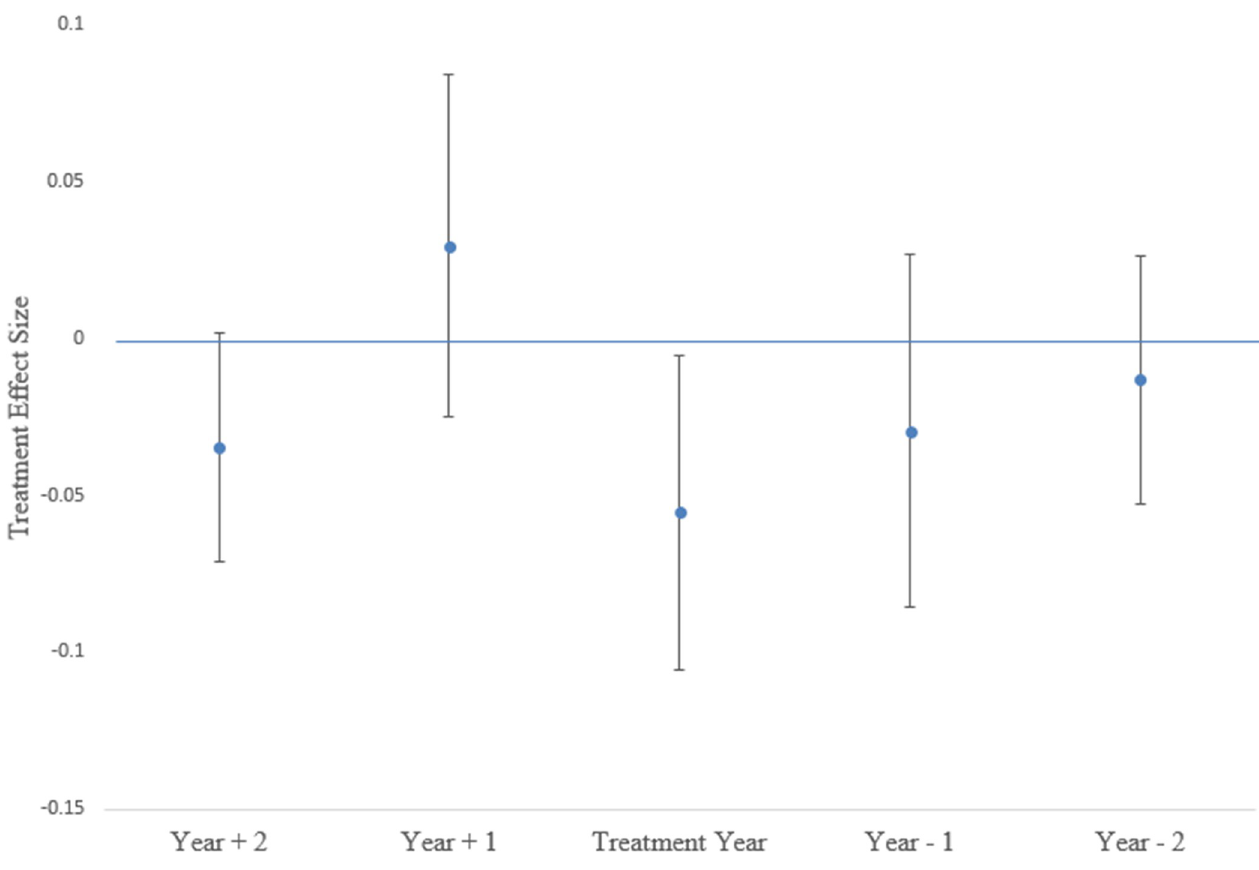
Fig 5. Results of distributed lag-lead